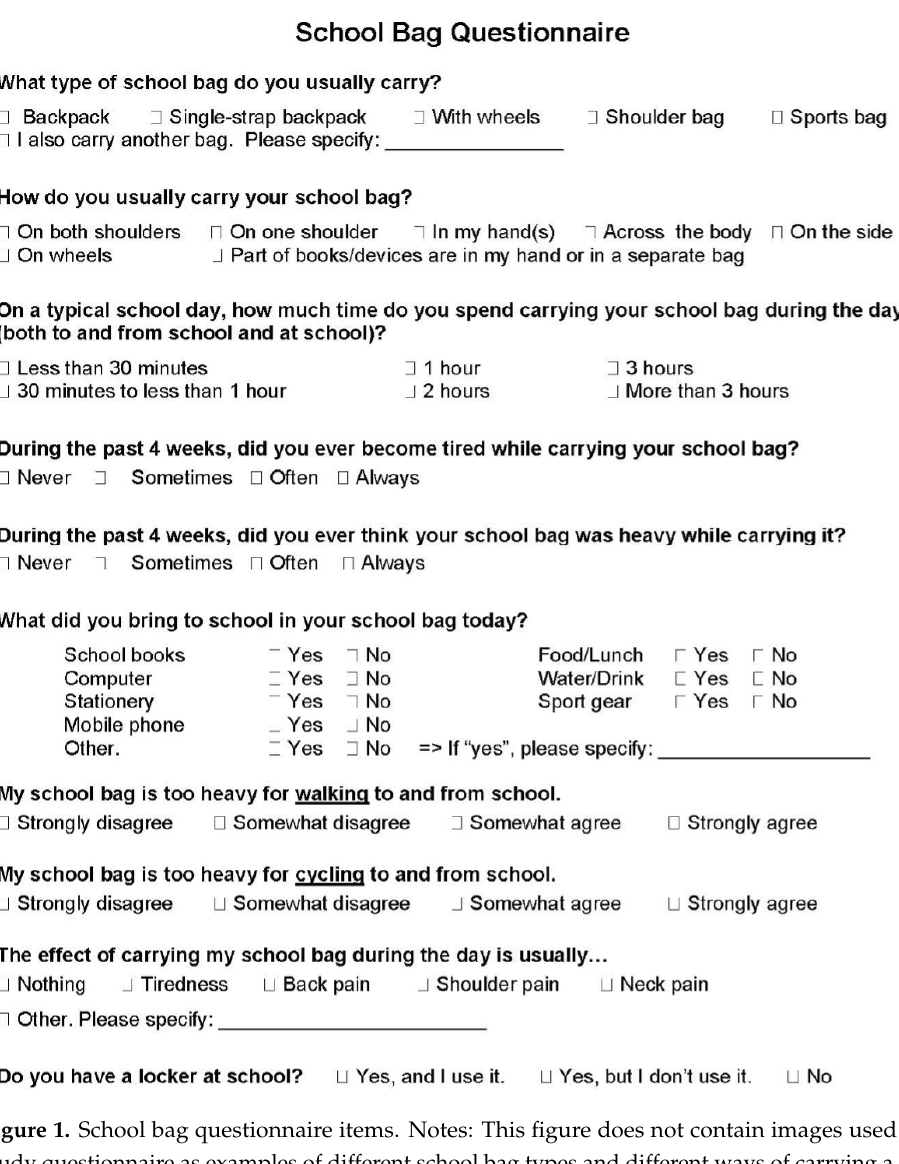
used in the analysis. International age- and sex-specific cut-off points for body mass index (BMI; weight divided by height squared (kg · m − 2 )) were used to determine adolescents’ body weight status categories, with BMI < 17 kg · m − 2 indicating underweight [29].